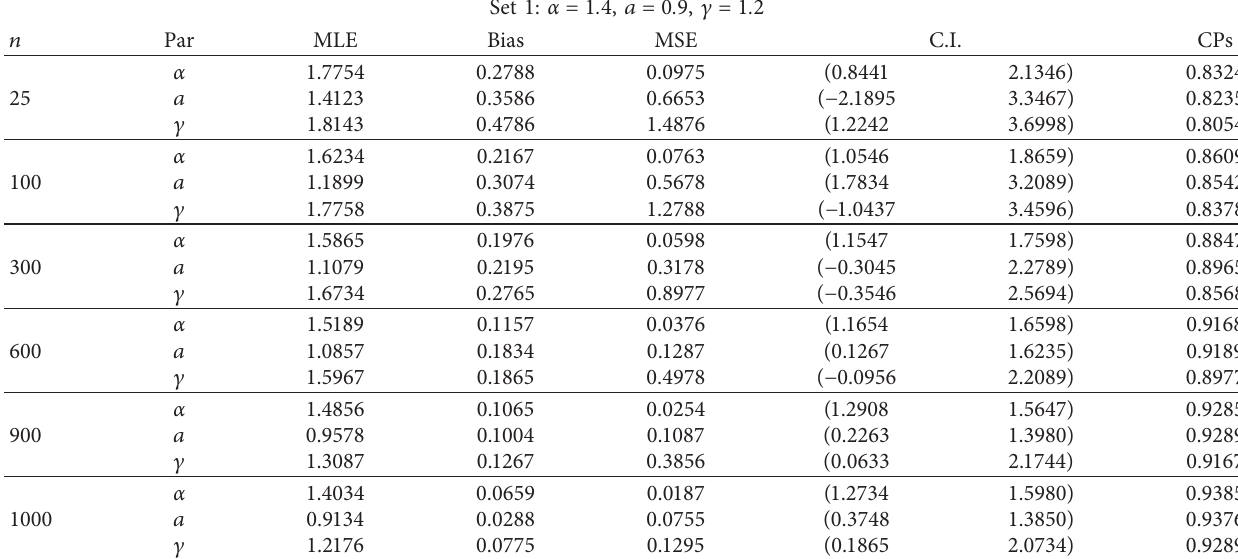
Table 2: MLE, Bias, MSE, C.I., and CPs of the ASE-W parameters.